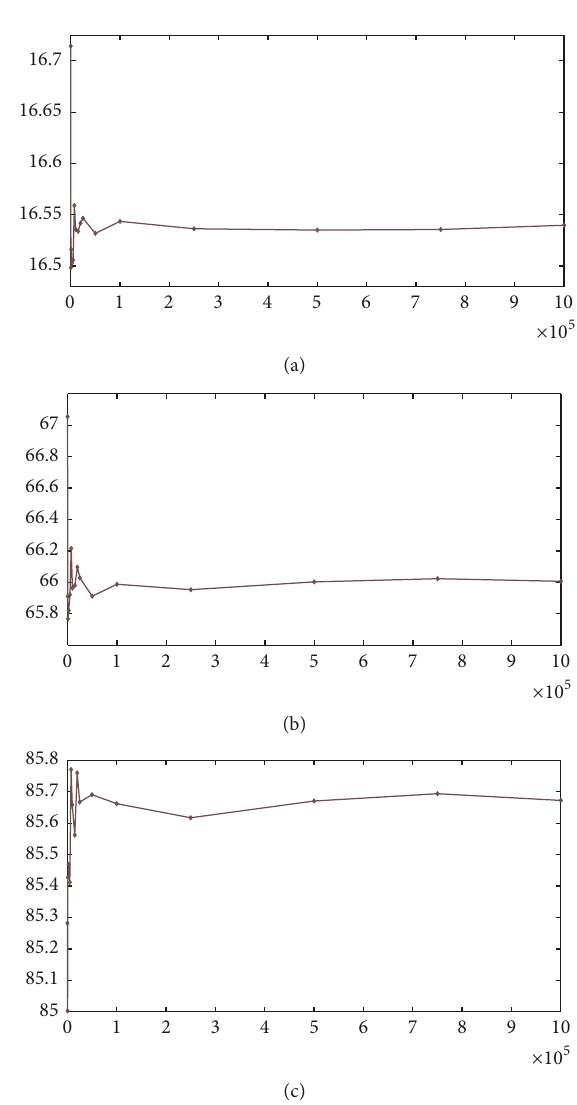
Figure 6: Fitting performance for monthly number of deaths (a) and injuries (b) with ARIMA (2,1, 3) and for monthly number of incidents (c) with ARIMA (0, 1,1)